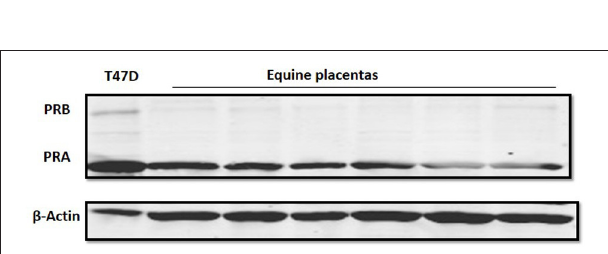
FIGURE 3 | Progesterone receptor protein expression in equine placental tissue at term ( n = 6). Immunoblot data show PRA and PRB, as well as β -actin as a loading control band. The T47D lysate was used as a positive control for PRA and PRB bands.